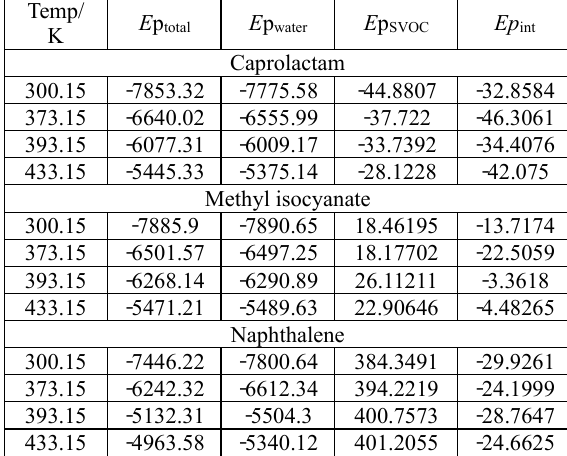
Table 2. Calculated interaction energies (kcal/mol) of SVOCs and water molecules Temp/